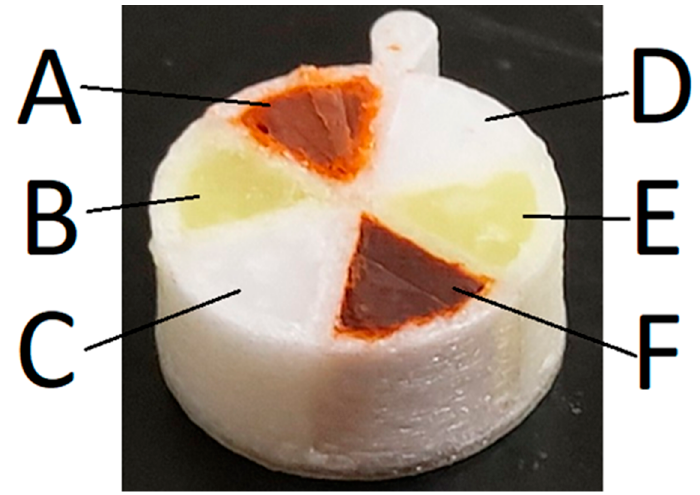
Figure 4. 3D-printed multicompartment PLH constructed from PVOH containing drug + formulation ( A ) 7% CLO:SMEDDS, ( B ) 7% LUM:SMEDDS, ( C ) 3.5% HAL:SMEDDS, ( D ) 7% CLO:Gelucire®48/16, ( E ) 7% LUM:Gelucire®48/16, and ( F ) 3.5% HAL:Gelucire®48/16.